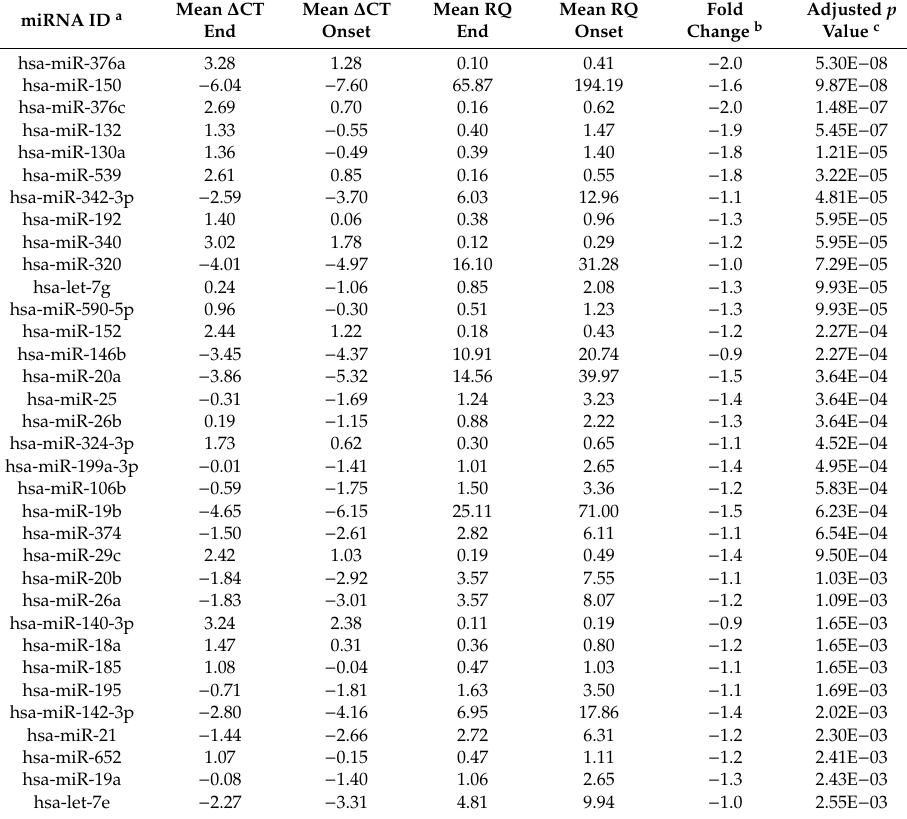
Table 2. Di ff erentially expressed exo-miRNAs at the end of induction chemotherapy. Mean ∆ CT Mean ∆ CT Mean RQ miRNA ID a End Onset End